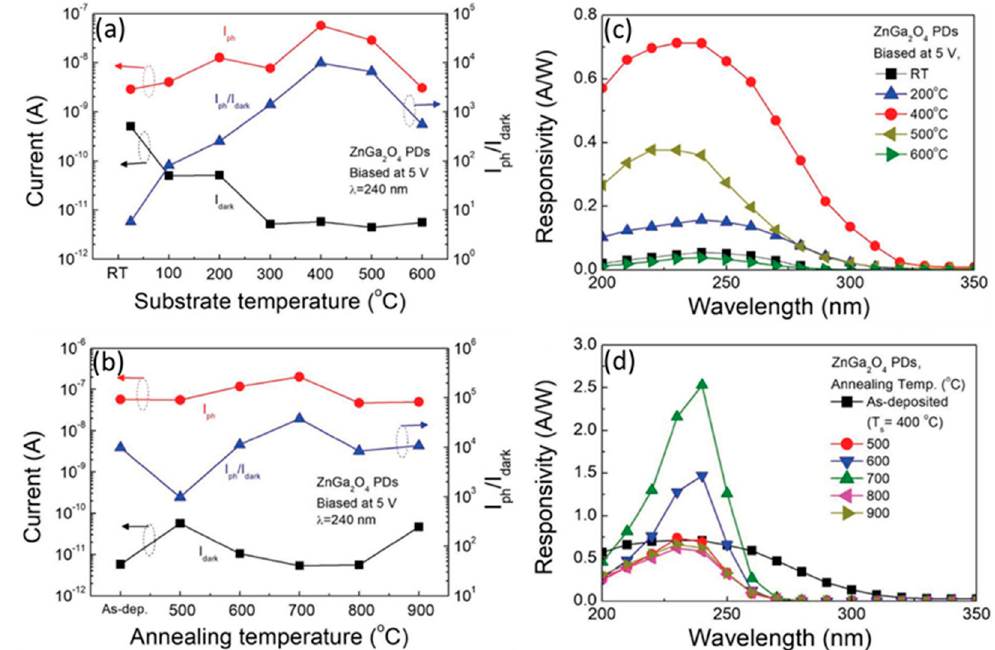
Figure 23. The photocurrent (I ph , red circles), dark current (I dark , black squares), and I ph /I dark current ratio (blue triangles) of the ZnGa 2 O 4 photodetectors (PDs) as a function of ( a ) substrate temperatures (T s ) from 25 to 600 °C and ( b ) annealing temperature (T a ) from 500 to 900 °C, which were prepared under the incident light wavelength of 240 nm. The responsivities of ZnGa 2 O 4 PDs as a function of wavelength with various ( c ) substrate temperature T s and ( d ) annealing temperature T a [90]. (with copyright permission from John Wiley and Sons, 2020).